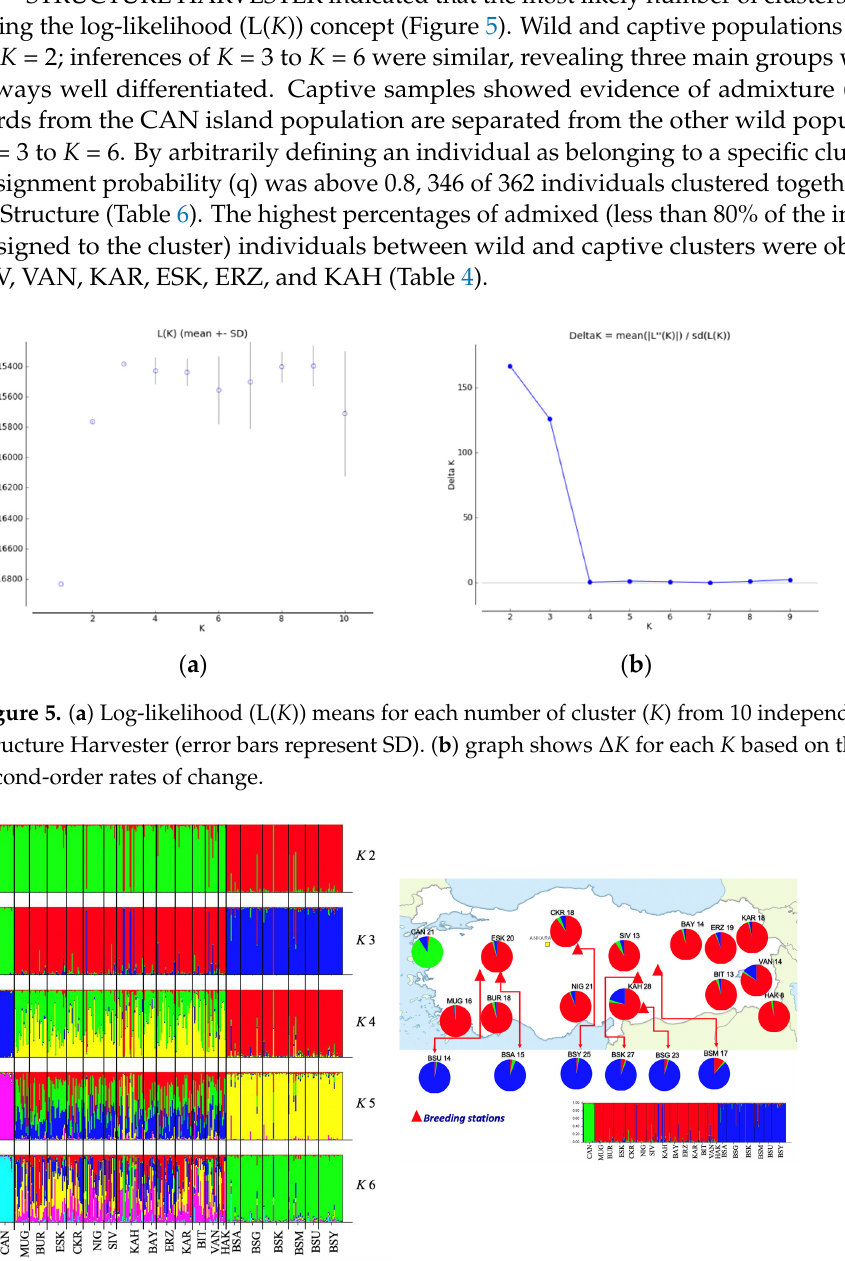
Figure 6. STRUCTURE assignment of 362 individual microsatellites for K = 2 to K = 6. Each individual genotype is represented by a vertical bar. Black lines separate the 20 different populations, 14 wild and six captive. The most likely number of clusters is K = 3. Besides, CAN